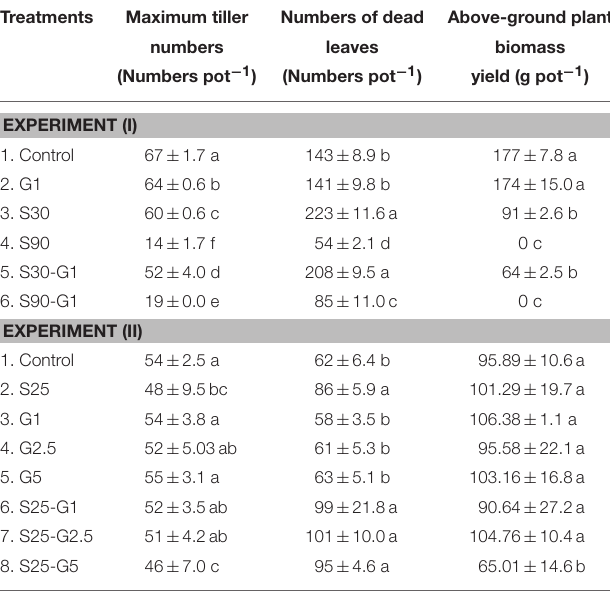
TABLE 3 | Effect of different salinity levels and different rates of gypsum amendment upon rice